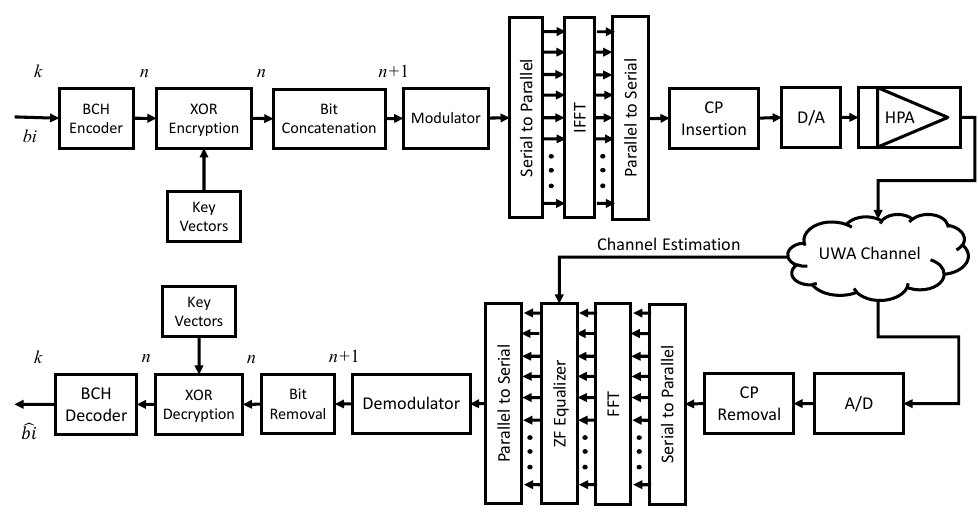
Figure 1. Proposed ciphered BCH OFDM architecture.